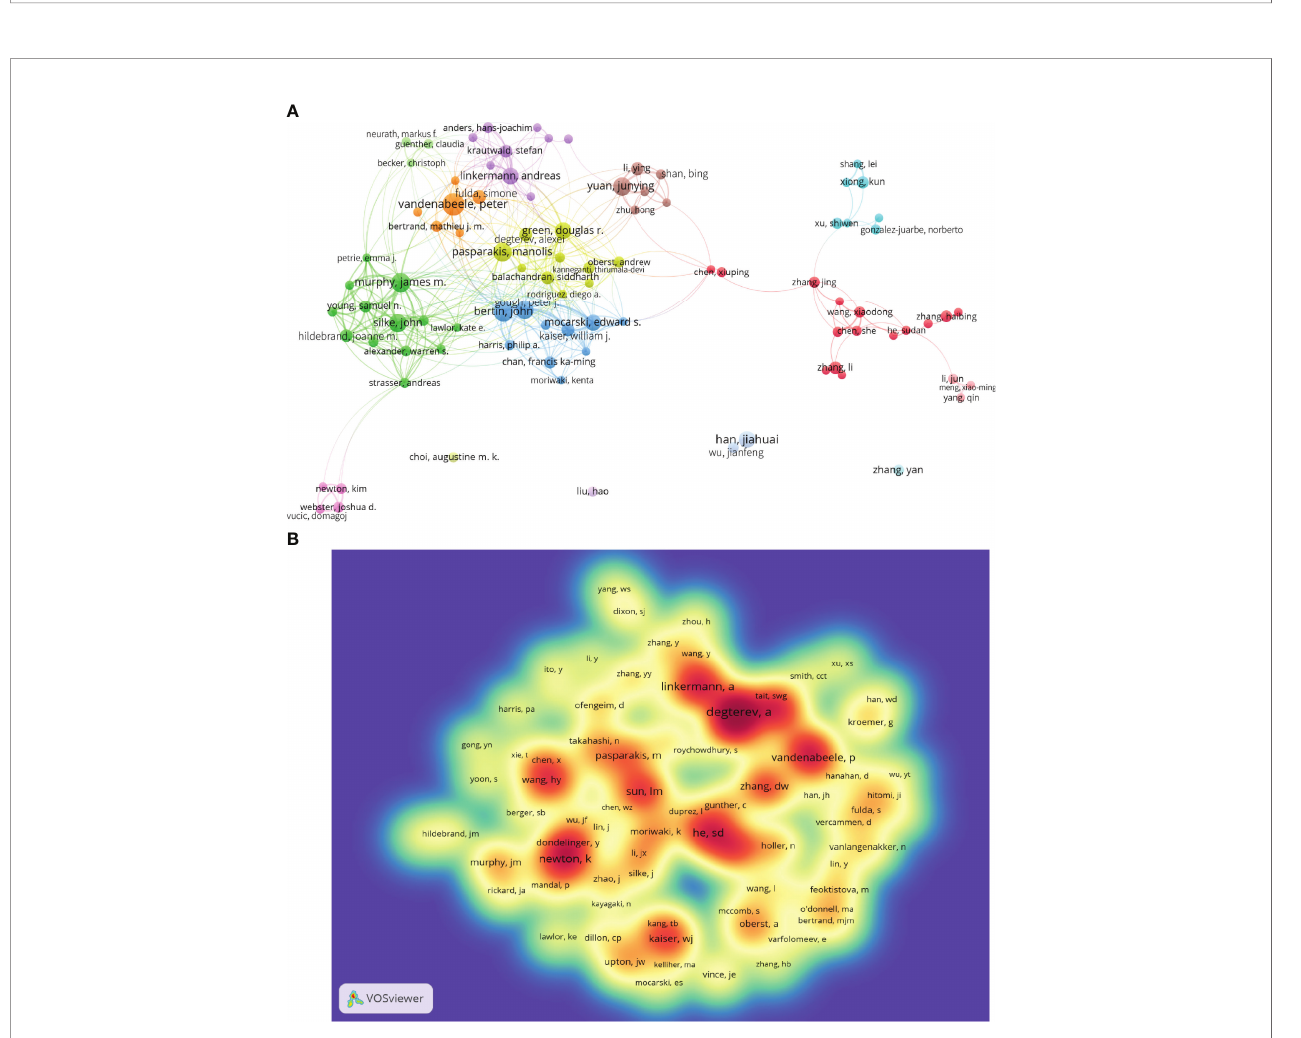
FIGURE 4 | The co-occurrence authors ’ (A) and co-cited authors ’ (B) map of necroptosis research. (A) Authors with documents ≥ 10 (cluster map). The size of node re fl ects the authors ’ co-occurrence frequencies, the link indicates the co-occurrence relationship between authors, the thickness of the link is proportional to the number of publications two researchers have co-authored, and the same color of node represents the same cluster. (B) Co-cited authors with citations ≥ 100 (density map). The size of word, the size of round, and the opacity of yellow are positively related to the co-cited